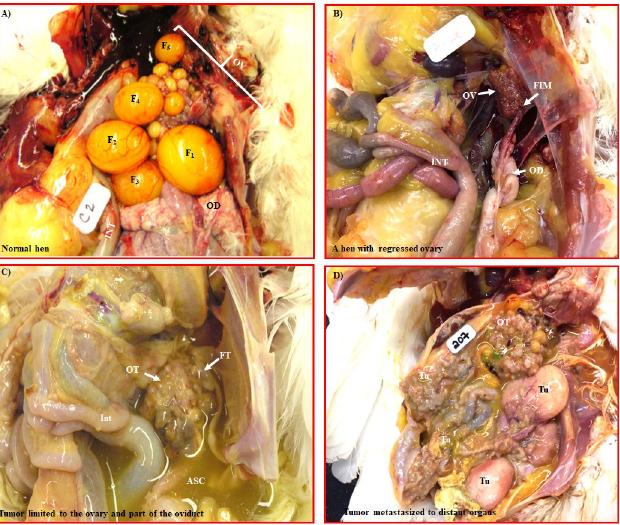
Fig 1. Gross presentation of normal ovaries and ovaries with tumors in laying hens. A) A normal fully functional ovary in a healthy laying hen showing a hierarchy of preovulatory follicles (F 1 -F 5 ). B) A normal ovary in an older hen with ceased laying activity. The ovary is regressed, no preovulatory follicle is seen in the ovary and no abnormalities are observed at gross. Functionally, this ovary resembles a postmenopausal ovary in a woman. C) Tumor in ovary involving the fimbria of the infundibulum of the oviduct. The tumor is at early stage and is accompanied with moderate ascites. D) Ovarian cancer (OVCA) at late stage in a hen. Compared with early stage, the tumor in late stage showed extensive metastasis with solid masses formed in distant organs. ASC = Ascites, F 1 to F 5 = Hierarchical follicles: F 1 = The largest follicle destined to ovulate soon followed by F 2 , F 3 , so on, FIM = Fimbria, FT = Tumor in fimbria, INT = Intestine, OD = Oviduct, OV = Ovary, OT = Ovarian tumor, Tu =